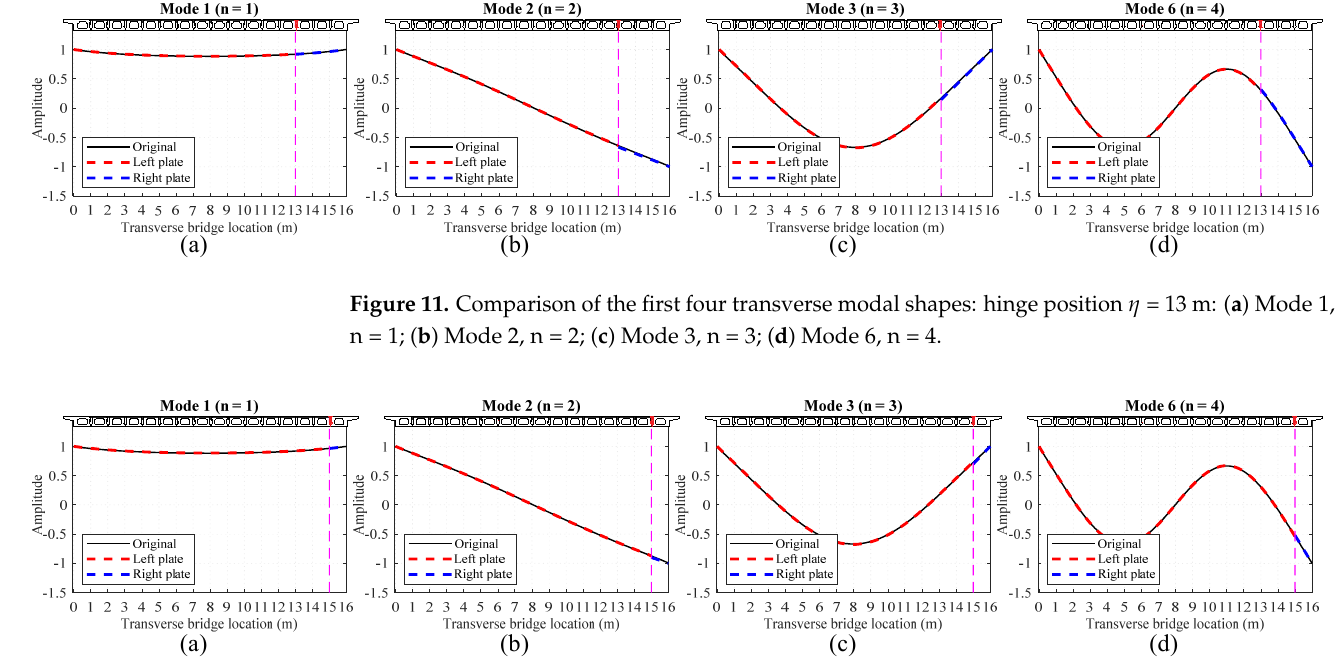
Figure 10. Comparison of the first four transverse modal shapes: hinge position η = 11 m: ( a ) Mode